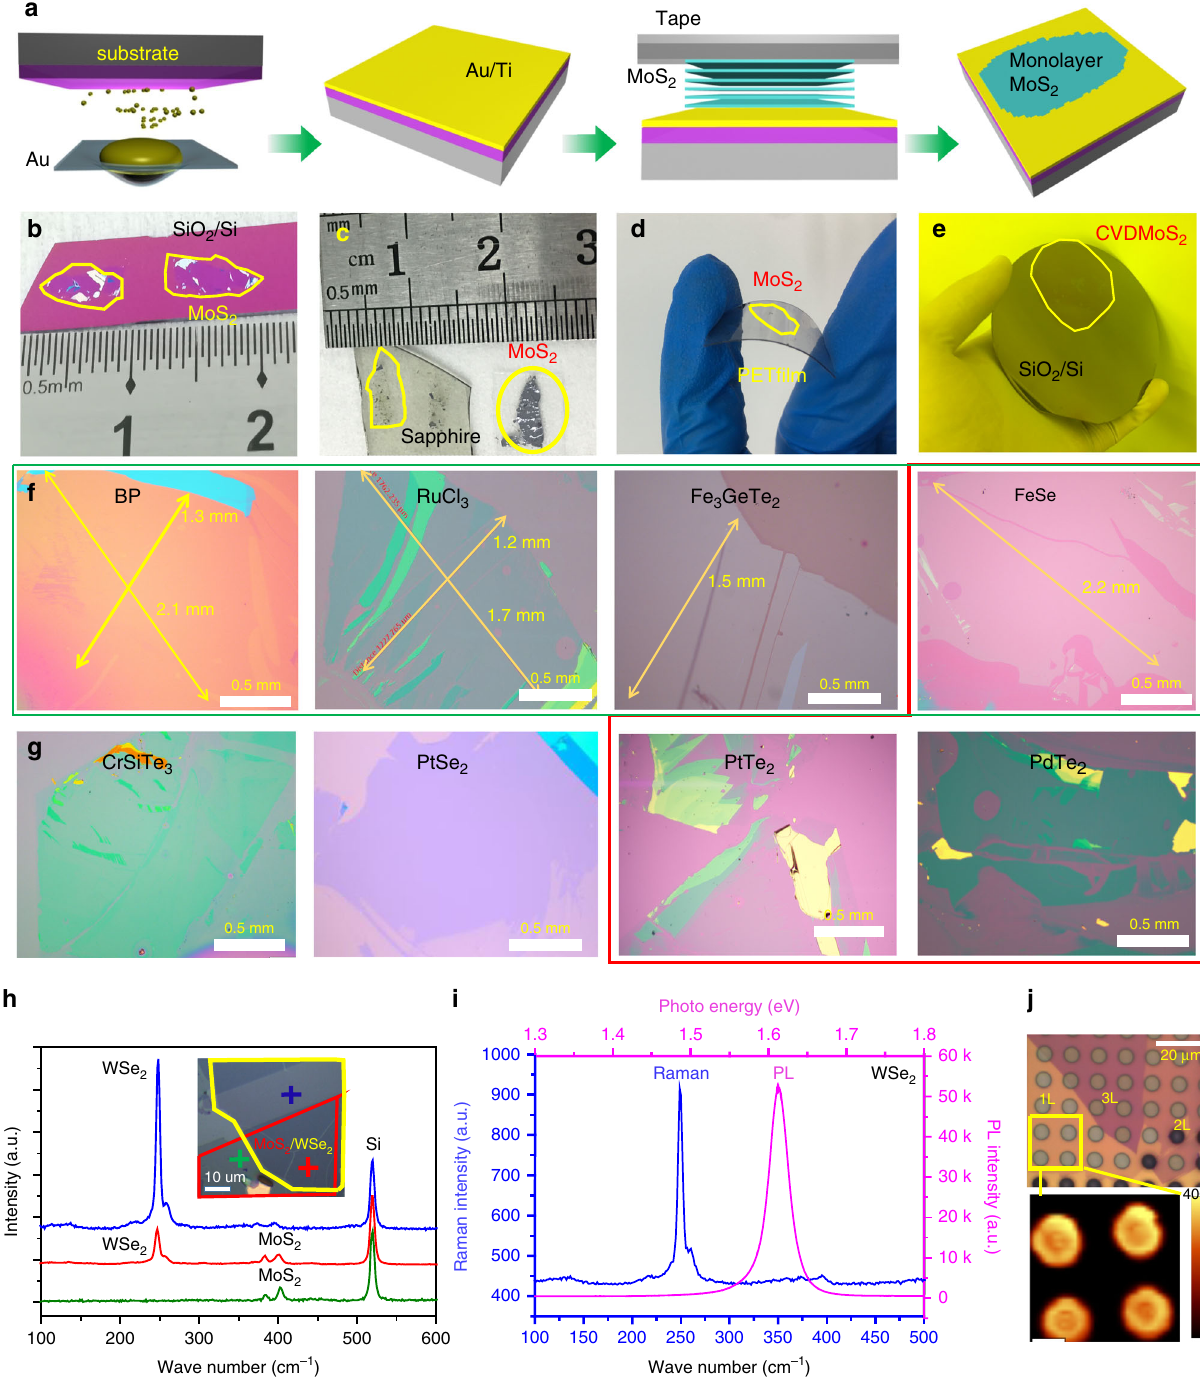
Fig. 2 Mechanical exfoliation of different monolayer materials with macroscopic size. a Schematic of the exfoliation process. b – d Optical images of exfoliated MoS 2 on SiO 2 /Si, sapphire, and plastic fi lm. e 2-inch CVD-grown monolayer MoS 2 fi lm transferred onto a 4 inch SiO 2 /Si substrate. f – g Optical images of large exfoliated 2D crystals: BP, FeSe, Fe 3 GeTe 2 , RuCl 3 , PtSe 2 , PtTe 2 , PdTe 2 , and CrSiTe 3 . Those exfoliated monolayers highlighted in the red box are, so far, not accessible using other mechanical exfoliate method. h Optical image and Raman spectra of a MoS 2 /WSe 2 heterostructure. i Raman and photoluminescence (PL) spectra of suspended monolayer WSe 2 . j Optical image of suspended WSe 2 with different thicknesses (1 L to 3 L) and a PL intensity map of the suspended A-exciton PL peak at 1.83 eV indicates the exfoliated MoS 2 on Au is still a direct-band gap semiconductor 36 . Metal substrates usually quench the PL intensity of monolayer MoS 2 23,24 ; however, our PL signal remains strong because of the thickness-tunable conductivity of our metal substrates, as elucidated later.